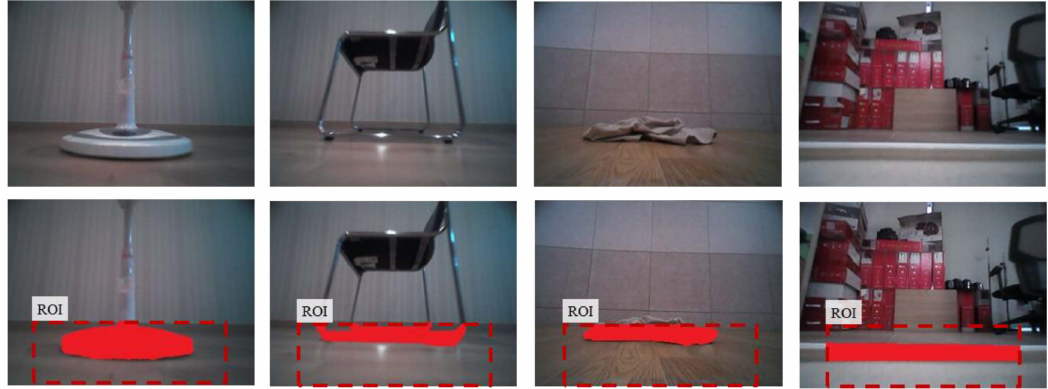
Figure 12. Examples of hand-labeled ground truth obstacle segmentation for quantitative analysis (upper row: original images, lower row: hand-labeled ground truth